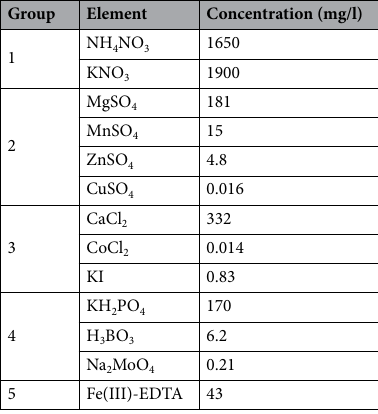
Table 1. Inorganic elements of Murashige and Skoog